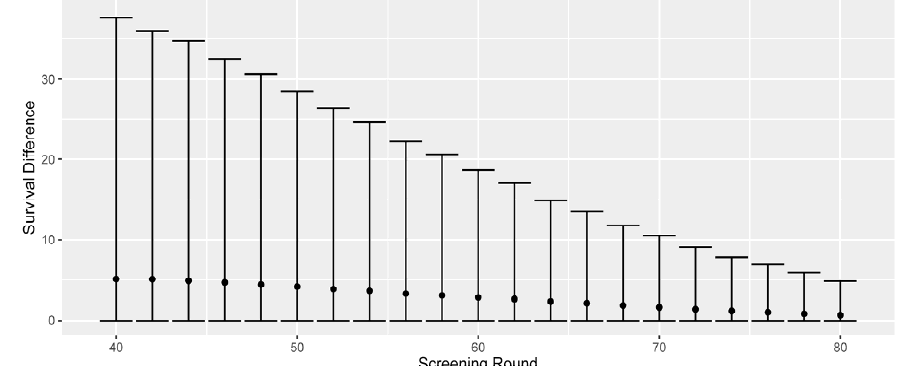
Figure 2. Differences in all-cause survival for screen-detected cases compared to their would-be symptomatic survival. The mean, 5th, and 95th percentiles are separated by screening round of detection. Numbers are based on aggregating ten simulations, each based on one million in silico women.